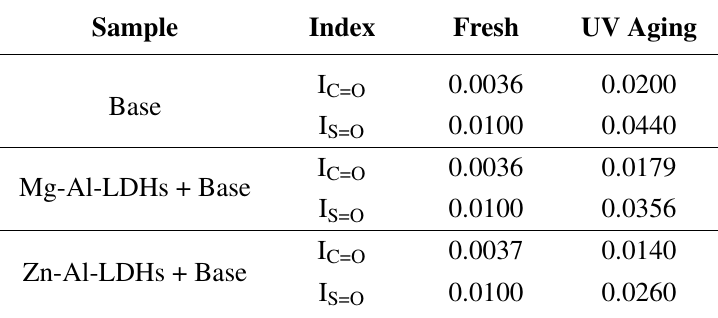
Table 3. Structure-change indexes of base and modified bitumens before and after UV aging.